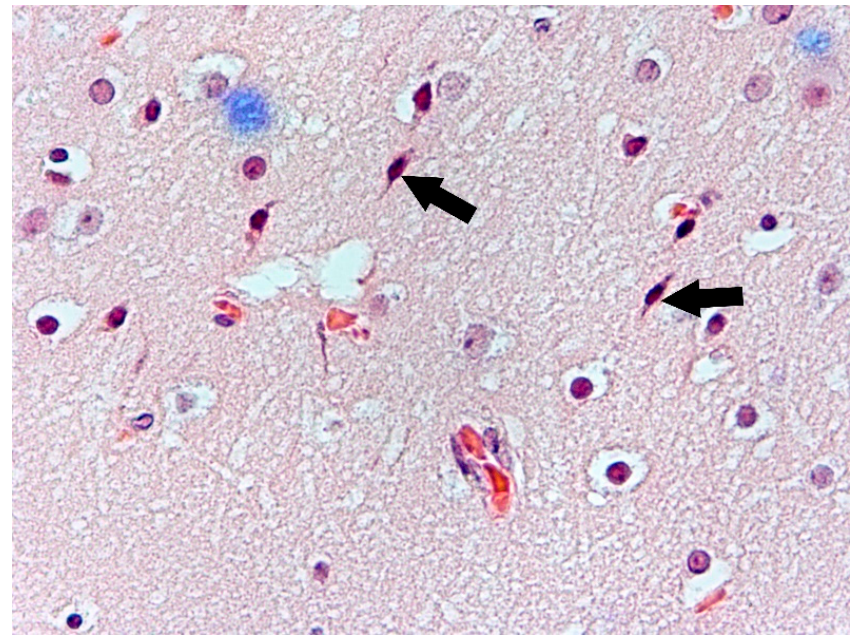
Figure 1. Case no. 4. Visible occipital lobe neurons (arrows) with nuclear hyperchromasia and pyknosis consistent with chronic ischaemic changes. H&E staining, magnification 400×.